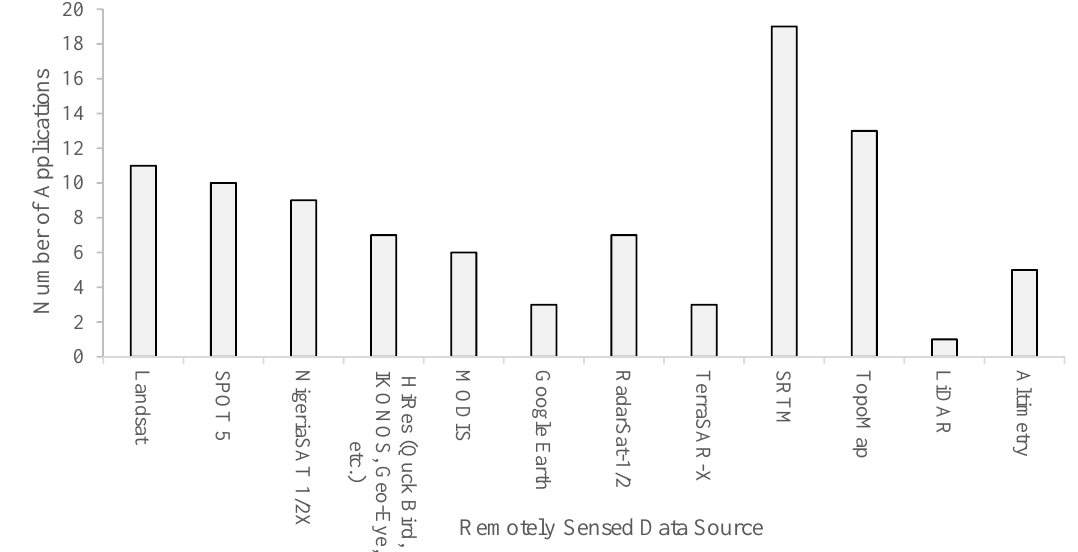
Figure 8. Remotely sensed data application in flood studies in Nigeria.